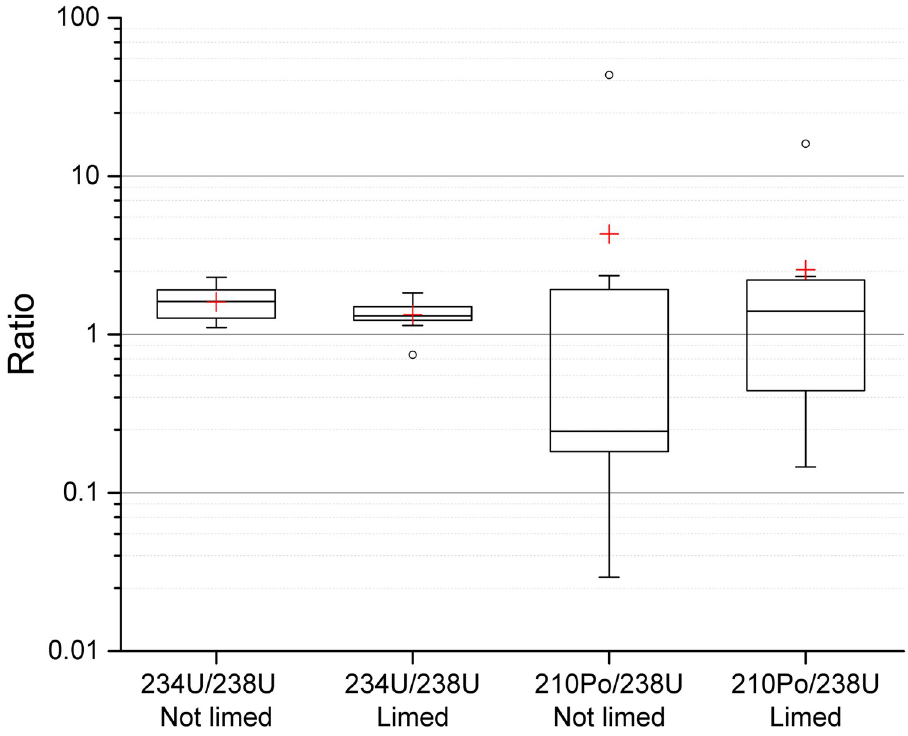
Fig 5. 234 U-to- 238 U and 210 Po-to- 238 U activity concentration ratios in surface water from limed and not limed pit lakes. The height of the box shows the interquartile range, which contains 50% of the values, the horizontal line inside the box shows the median value and the red cross denotes the mean value. The whiskers are lines that extend from the box to the highest and lowest values excluding outliers (o). Outliers represent those data with values being 1.5 higher or lower than the height of the box. Detailed data are given in supplementary data